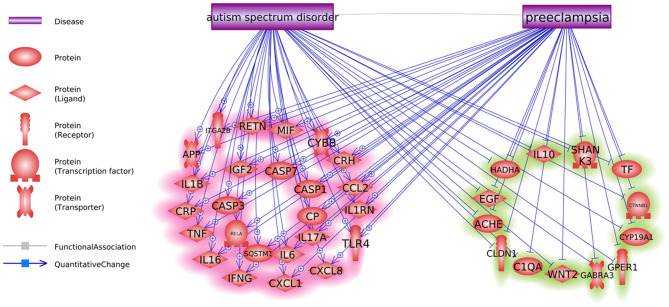
Co-directional regulatory influences exerted by PE and ASD.